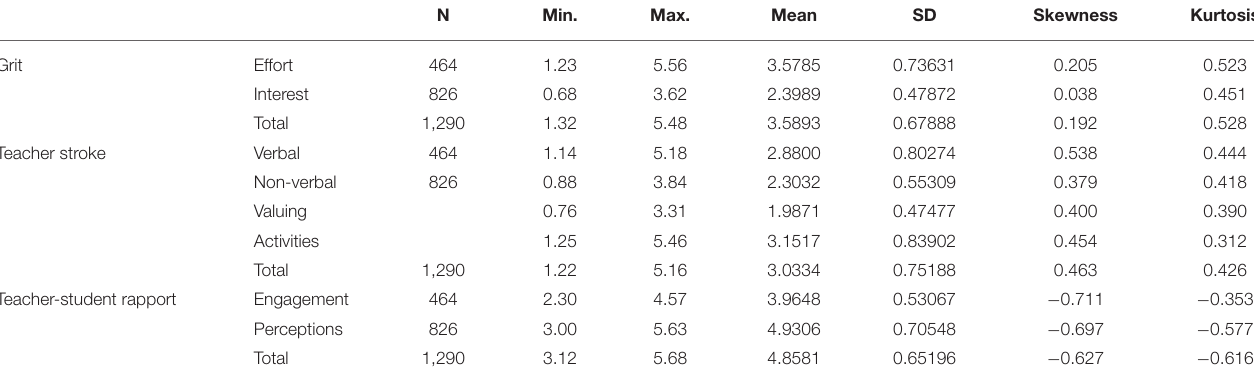
TABLE 4 | Descriptive statistics of the scores after regression imputation ( N = 282).